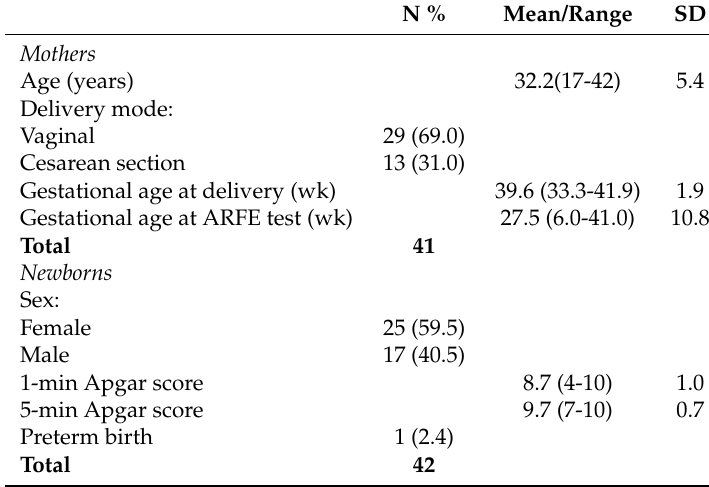
Table 1. Descriptive analysis of the characteristics of mothers and newborns in the study